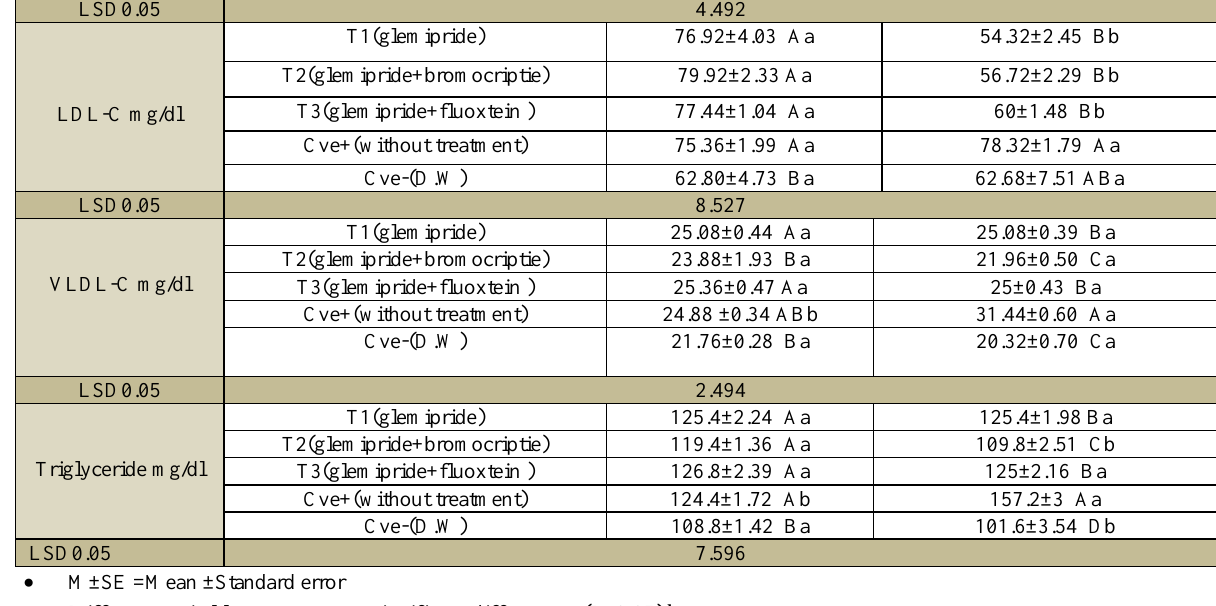
 M±SE =Mean ±Standard error  Different capital letters represent significant differences (P≥0.05) between groups  Different small letters represent significant (P≥0.05) between